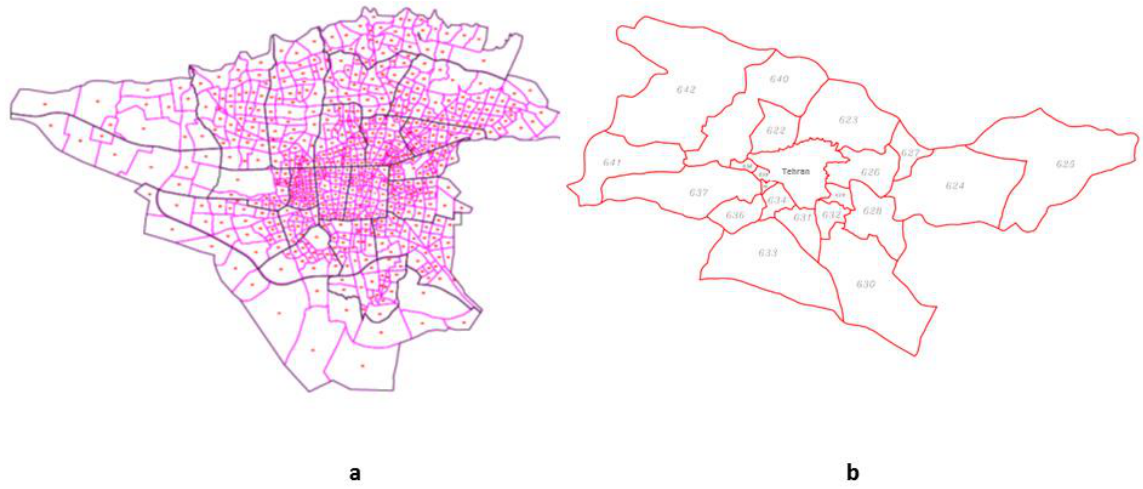
Figure 6: a) Zoning of Tehran for household travel survey, b) External zones of